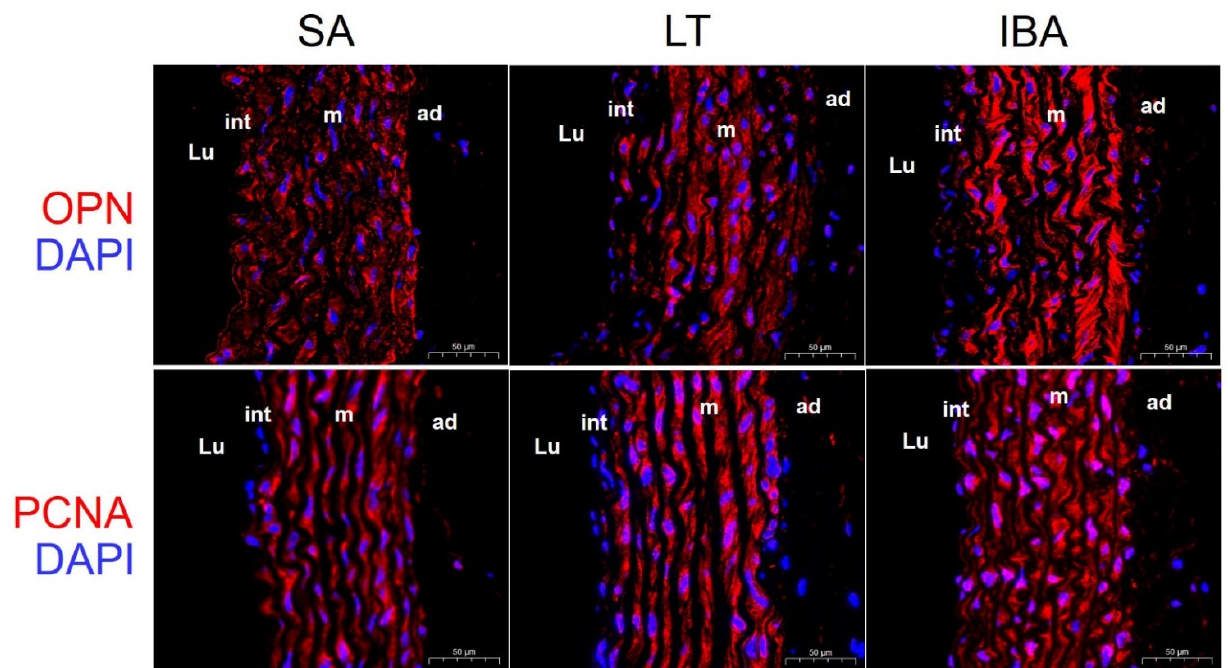
Figure 8. Immunofluorescence staining of OPN and PCNA in thoracic aorta. DAPI (blue) labels the nucleus, and CY3 (red) labels OPN and PCNA. The scale bar is 50 μm. SA: summer active, LT: late torpor, IBA: interbout arousal, Lu: lumen, int: intima, m: media, ad: adventitia.